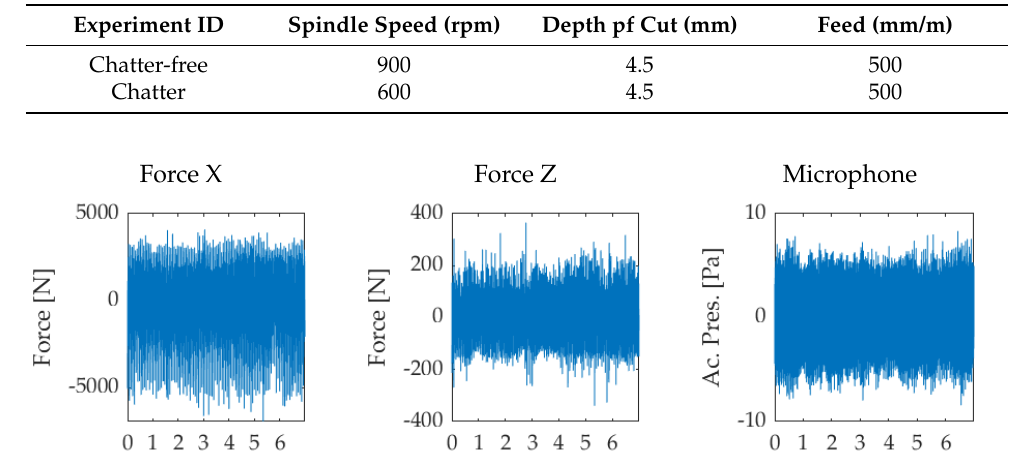
Table 2. Case 1: Experiment parameters